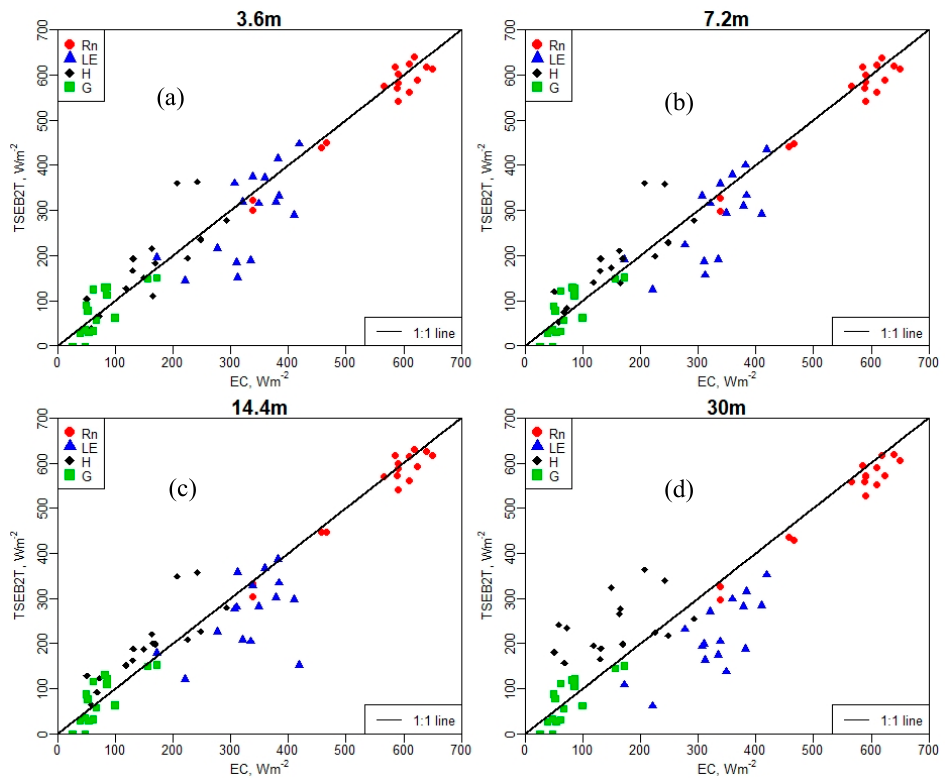
Figure 6. Scatterplot of observed versus estimated surface fluxes using different model grid sizes/resolution with the TSEB2T model; ( a ) 3.6 m, ( b ) 7.2 m, ( c ) 14.4 m, and ( d ) 30 m.